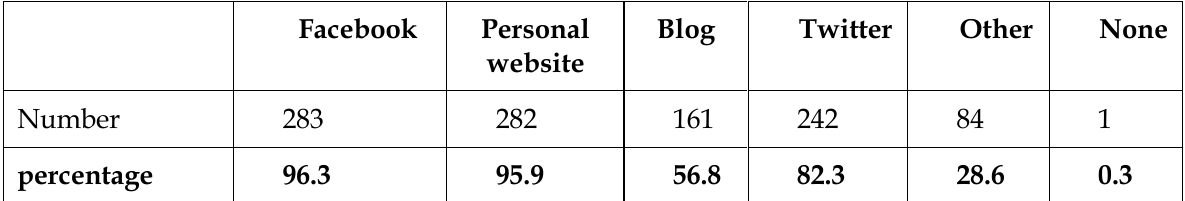
Table 1: number and percentage of Korean National Assembly members using social media in February 2016 (source: